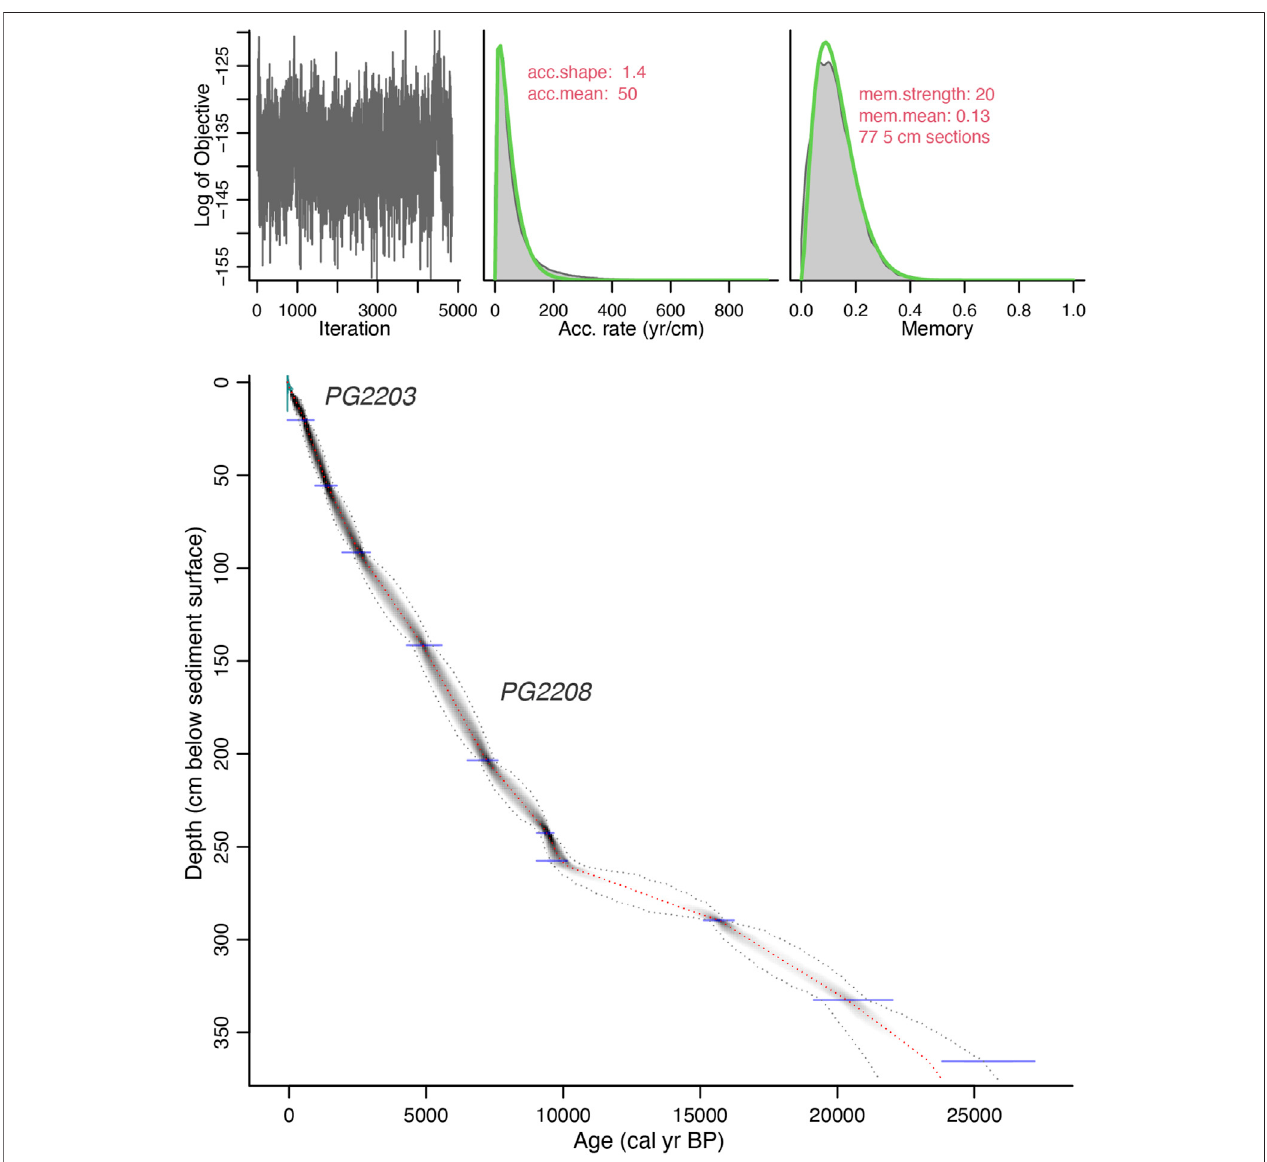
FIGURE 2 | Bacon age-depth model based on radiocarbon data from sediment core PG2208 (367 cm) and 210 Pb and 137 Cs dating from the uppermost 4 cm of short core PG2203.